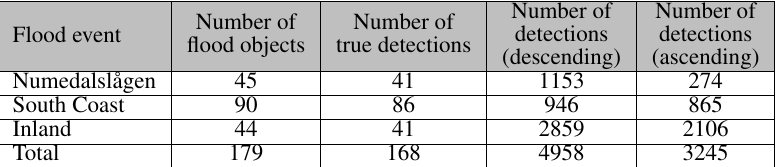
Table 5. Object-wise flood detection